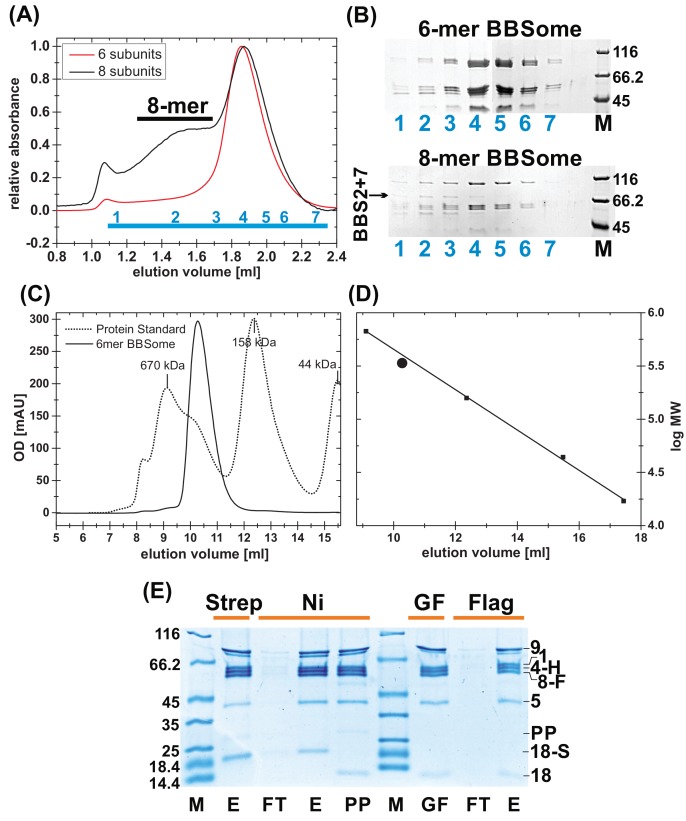
Purification of BBSome complexes.(A) Gel filtration profile of BBSome complexes with 6 and 8 subunits. As can be seen in coomassie-stained SDS-PAGE of the gel filtration (GF) fractions (B), the affinity-purified core BBSome complex (six subunits) elutes as a monomeric species, while BBS2 and BBS7 only partially incorporate in the full eight subunit complex that elutes as an oligomeric species, separated from the 6mer. (C) Calibration of the gel filtration profile of the core BBSome with a standard mixture of proteins with known molecular weight. (D): The apparent molecular weight of the core BBSome (large sphere), as determined by a comparison with standard proteins (small squares) is slightly larger than its theoretical molecular weight. (E) Coomassie-stained SDS-PAGE of samples from the triple-affinity purification of the core BBSome complex. After initial Streptactin-affinity (Strep) and Nickel affinity (Ni) purifications, Prescission Protease (PP) was added to cleave off the tag on BBS18. After incubation for 12 hr at 4°C, aggregates were removed by gel filtration, and the pooled monomeric complex (GF) was further purified in a final Flag affinity purification step (E: Elution, FT: Flowthru). The three tags used for purification are a cleavable dual-Strep tag on BBS18 (18 s), a His-tag on BBS4 (4 hr) and a Flag-tag on BBS8 (8 F).